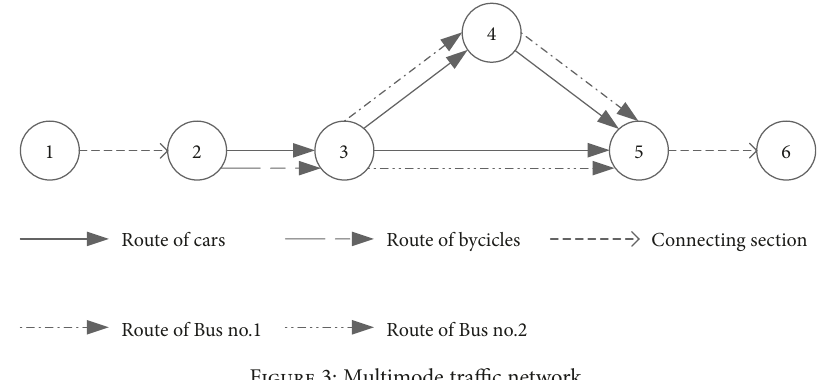
Figure 3: Multimode tra ffi c network.